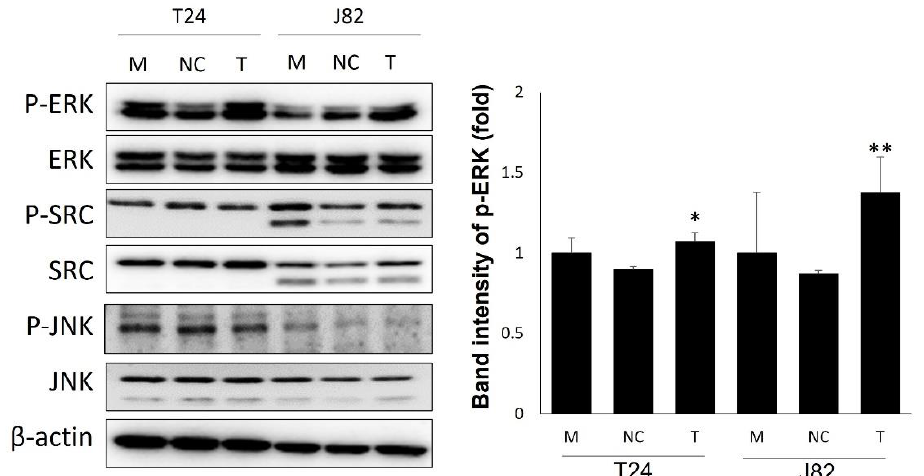
Figure 3. PDK4-related protein expression in PDK4 knockdown bladder cancer cells. β -actin is used as an internal control. M: mock, N: negative control, T: PDK4 siRNA treated. All data represent means ± SD of three independent experiments (* p < 0.05, ** p < 0.01 NC vs. T). M: mock, N: negative control, T: PDK4 siRNA treated.